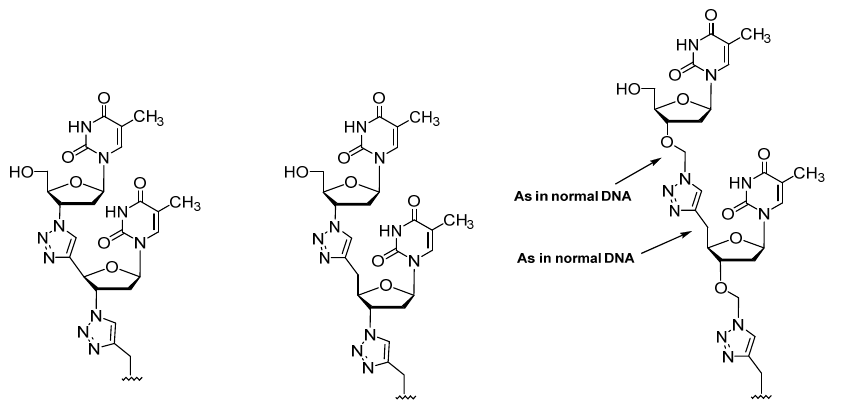
Figure 3. Triazole DNA template.